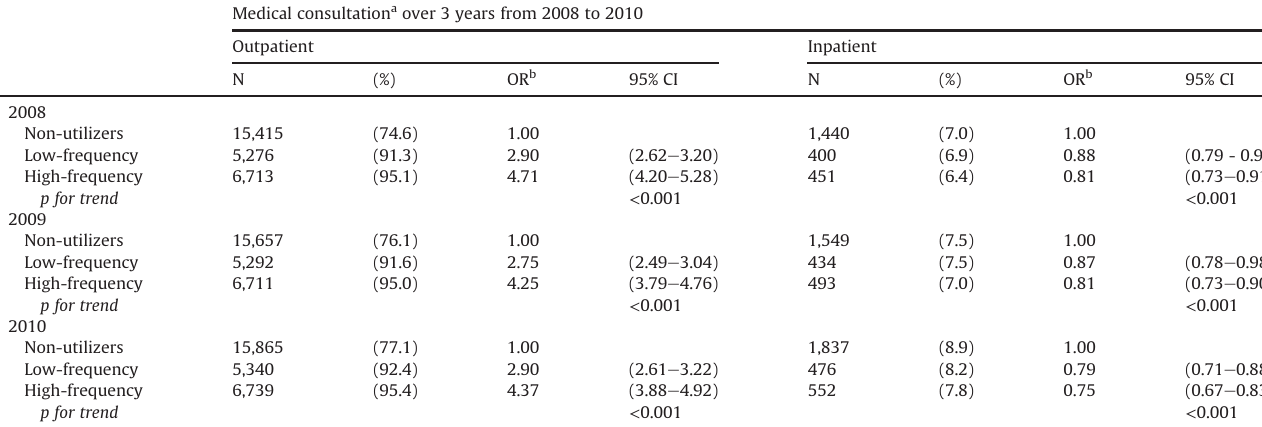
Table 2 Frequency of any medical consultation according to subgroups of general health checkup